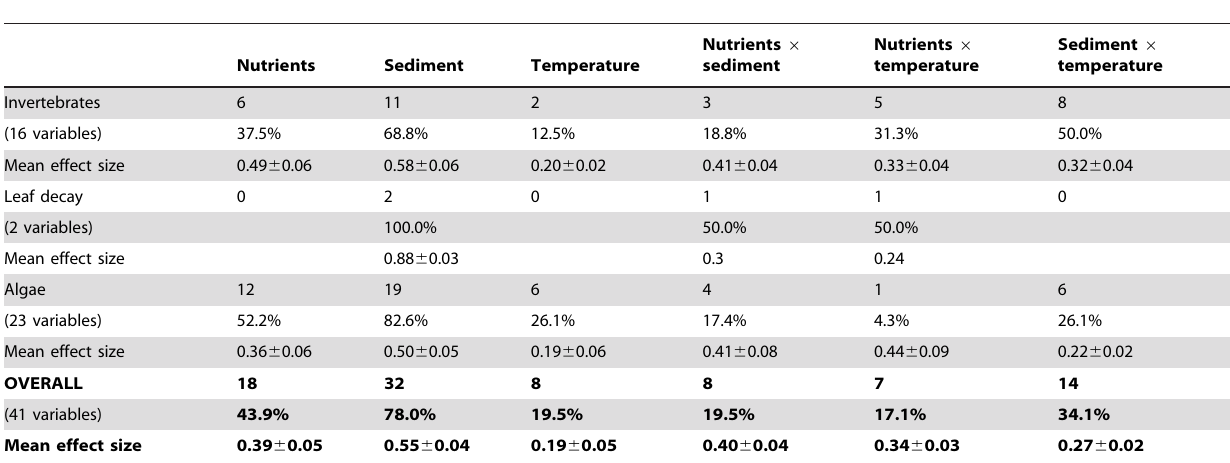
Table 3. Overview of results for biological response